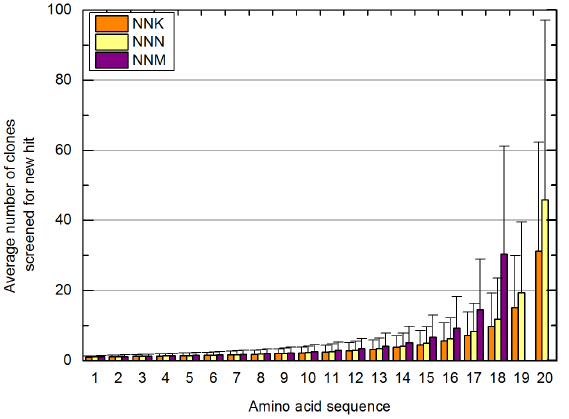
Figure 2. Simulation of random clone picking in randomized codon based saturation mutagenesis and calculation of the average number of clones needed to detect a new variant in libraries generated by NNK, NNN and NNM randomization.